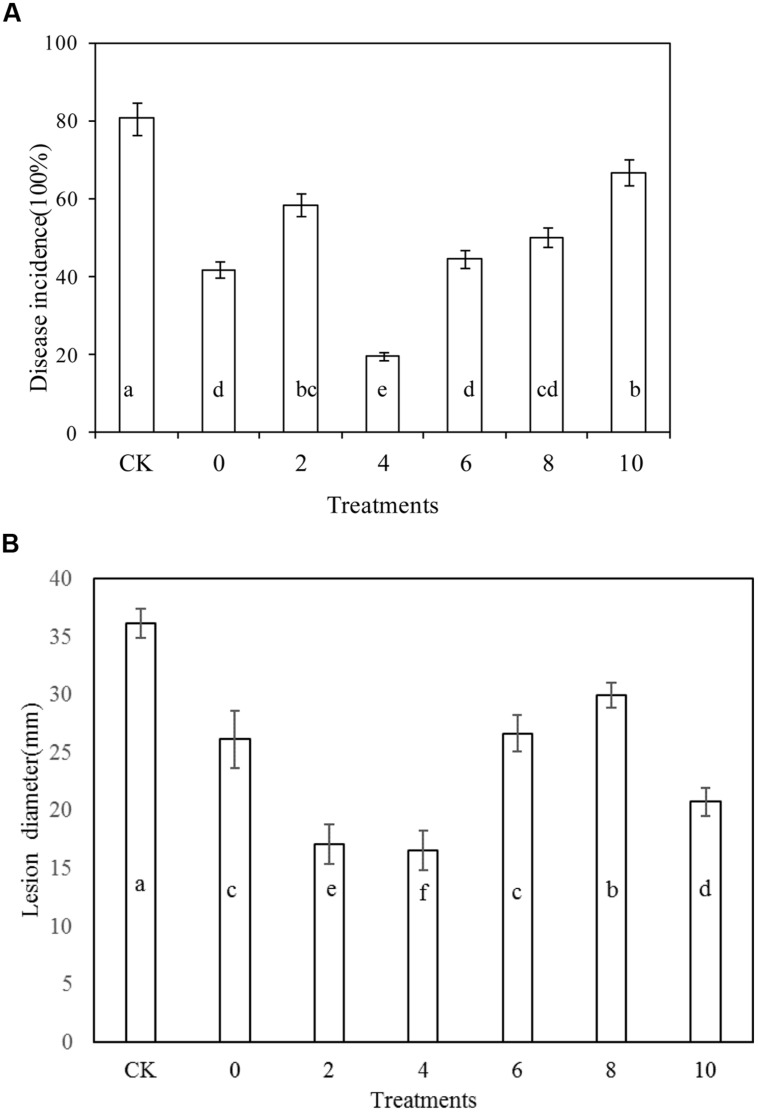
Effects of Rhodotorula mucilaginosa and PA on blue mold decay incidence on apples.
(A) Disease incidence, (B) Lesion diameter. Fruit treatments are as follows: CK = sterile distilled water, 0 = R. mucilaginosa (1 × 108 CFU ml-1), (2, 4, 6, 8, 10) = R. mucilaginosa (1 × 108 CFU ml-1) + PA at different concentrations (2, 4, 6, 8, and 10 μmol/ml). Each value is the mean of two experiments. Bars represent standard deviations. Different letters indicate significant differences (P < 0.05) according to the Duncan’s multiple range test and the data from each time point are separated.